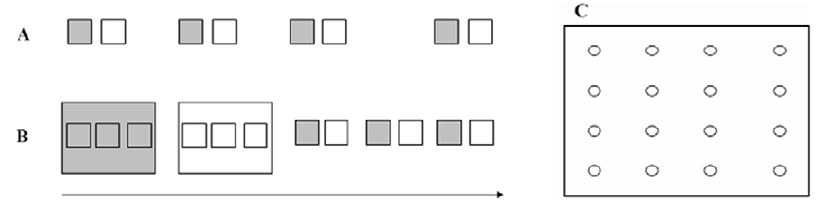
Figure 1. The experimental design in 2009 (A), 2010, and 2011 (B) and the sampling sites in each 20*20 m plot (C). Grey represents treated plots and white represents control plots. The size of the large plots in 2010 was 80*60 m. The arrows represent the spatial arrangement of the treated and control plots, where along the arrow (from left to right), the basic lines of ant abundances decreased, but the basic lines of beetle and spider abundances